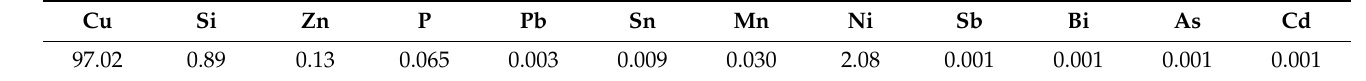
Table 1. Chemical composition of the tested CuNi2Si1 alloy